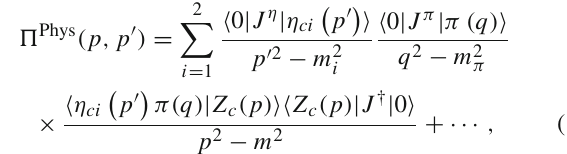
Fig. 2 The same as in Fig. 1, but for the coupling f of the resonance Z − c ( 4100